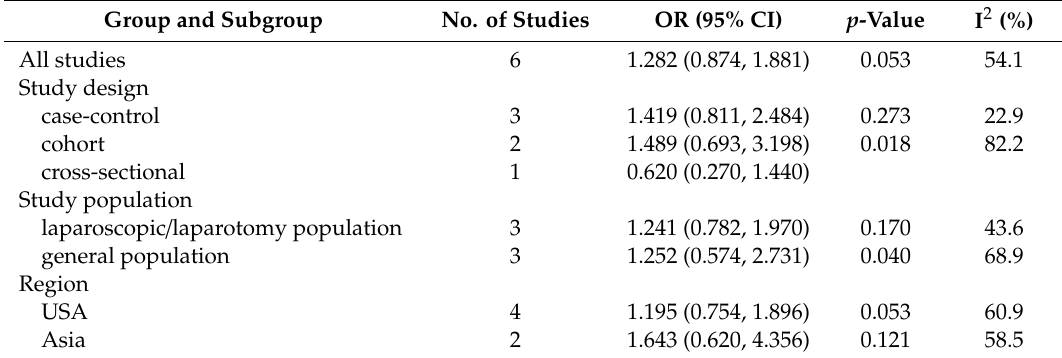
Table 7. Results of the Meta-Analyses of Studies of the Association between MEOHP and Endometriosis. Group and